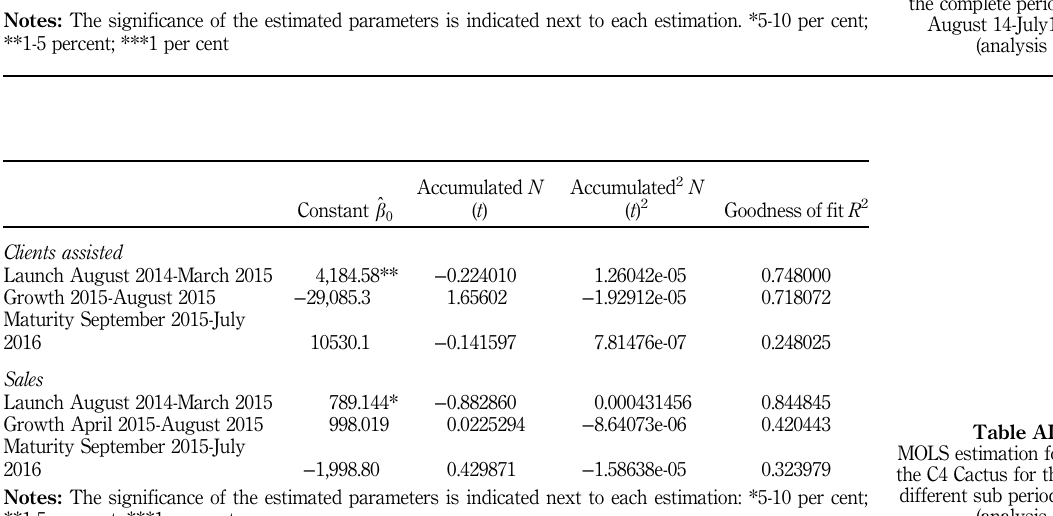
Table AII. MOLS estimation